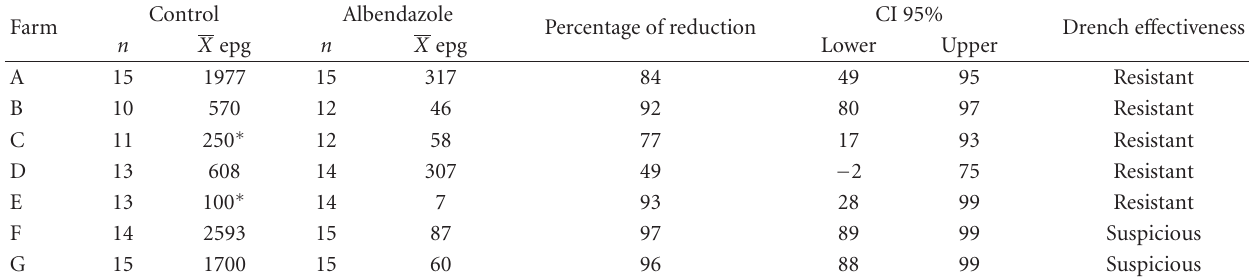
Table 2: Gastrointestinal nematode egg count percent reduction after treatment with ivermectin in seven flocks from Costa Rica.